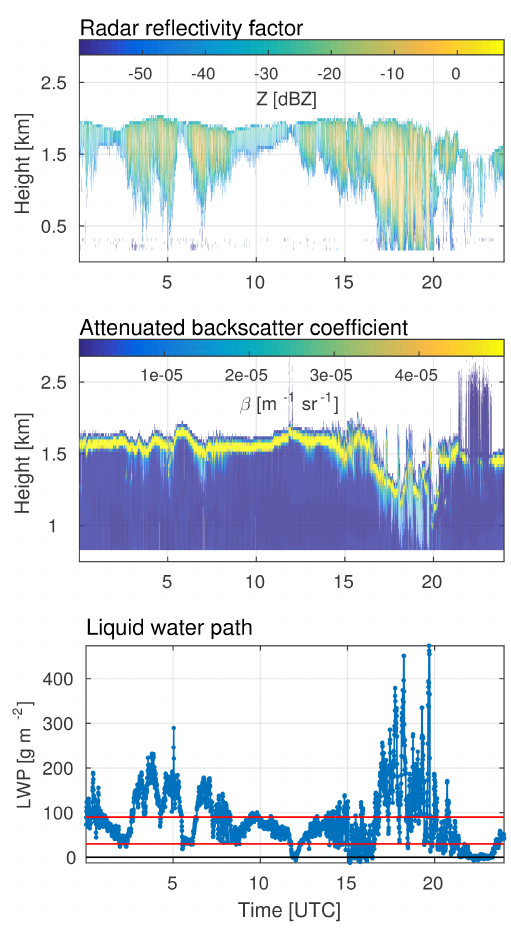
Figure 3. The time–height cross section of the radar reflectivity from WACR, the attenuated backscatter coefficient from Vaisala CT25K and the liquid water path from the MWR for a full day of measurements on 29 November